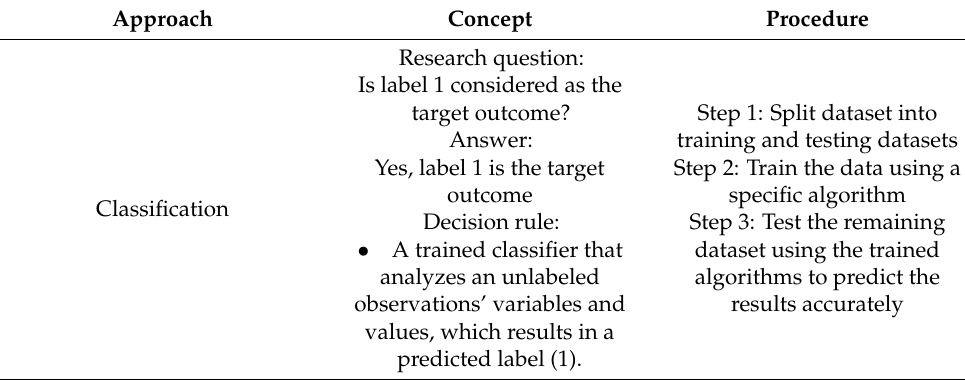
Table 2. Concepts in predictive analysis